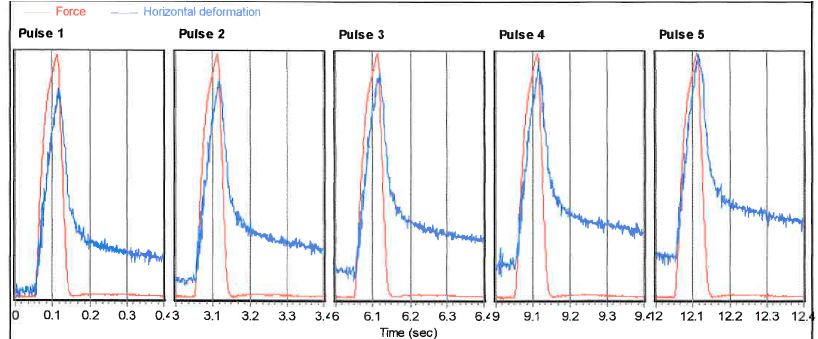
Table 10. Material combination for preparation of specimens of indirect tensile test.